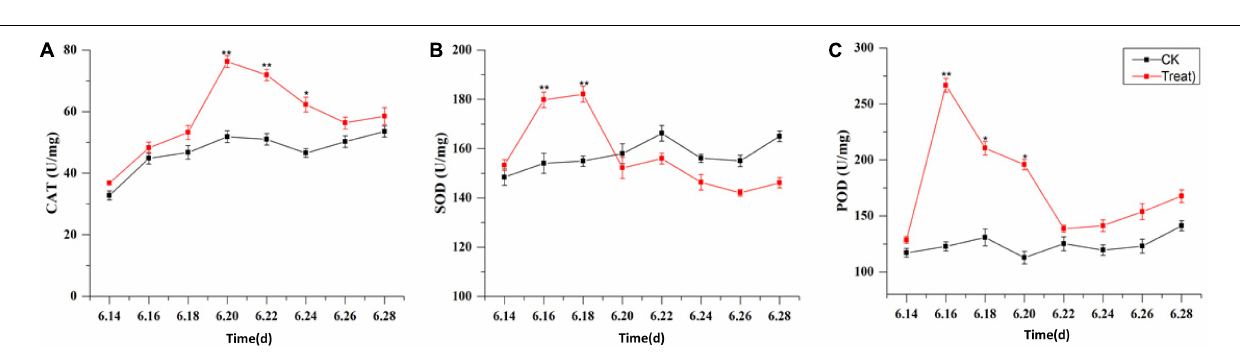
FIGURE 10 | Effects of cold stress on antioxidant enzymes in ginseng leaves during the flowering stage. Panels (A–C) show the CAT, SOD, and POD content under cold stress. The X axis represents the sampling time. * p < 0.05 and ** p < 0.01, compared with control group. The data are expressed as the mean ± SD ( n =